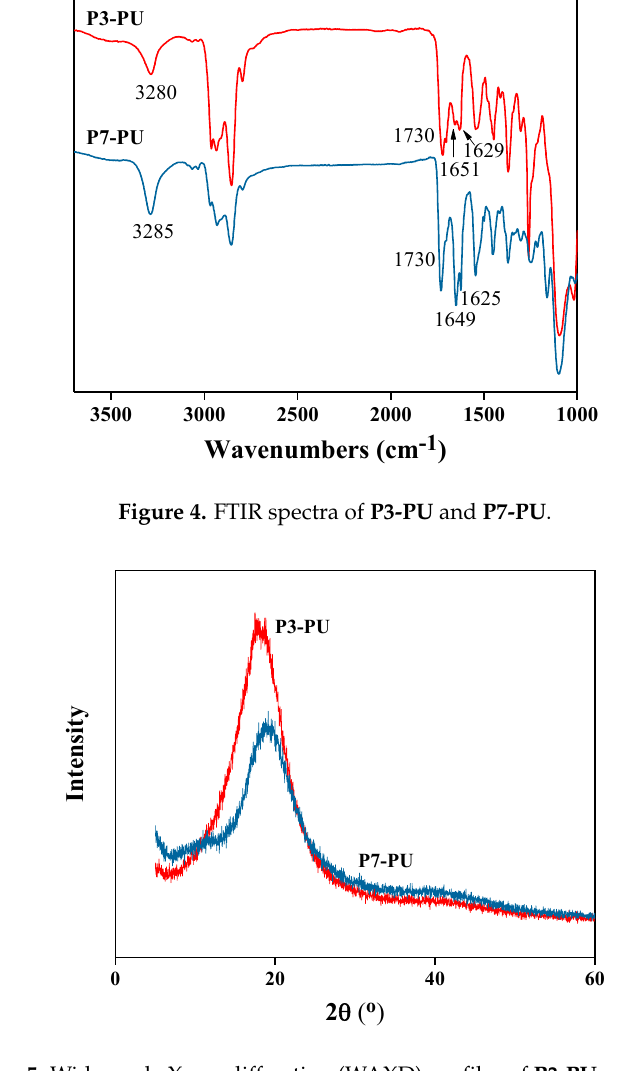
Figure 5. Wide angle X-ray diffraction (WAXD) profiles of P3-PU and P7-PU